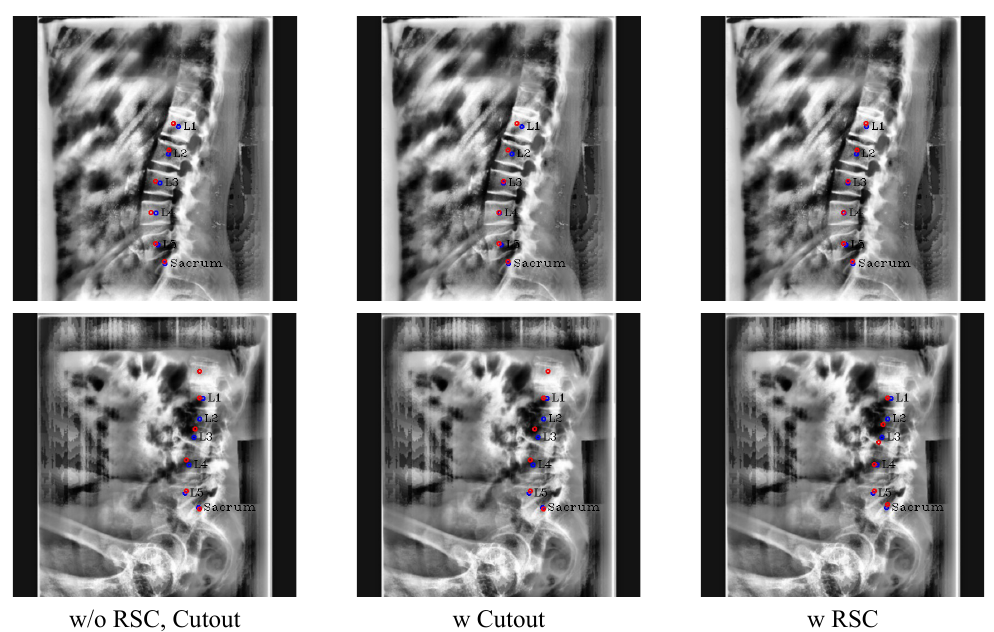
Figure 12. Results of ablation study with the conventional cutout and RSC. The red circles denote the predicated centers of L1, L2, L3, L4, L5, and the sacrum in order from the top, and blue circles and labels denote the ground truth of the